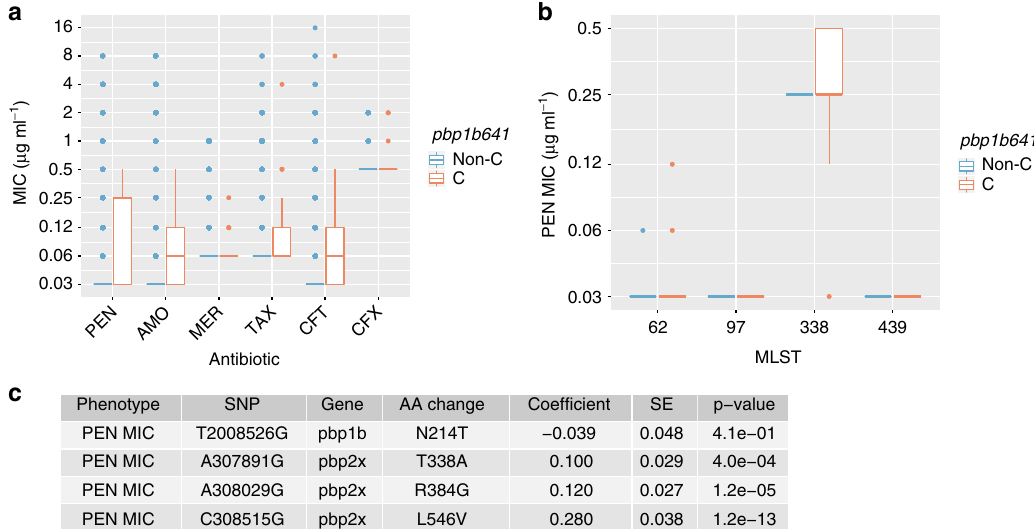
Fig. 3 Effects of pbp1b A641C on antibiotic resistance in clinical isolates. a Comparison of antibiotic MIC distribution between the non- pbp1b 641C isolates (blue) and pbp1b 641C isolates (orange) in the con fi rmatory cohort. PEN penicillin, AMO amoxicillin, MER meropenem; TAX cefotaxime, CFT ceftriaxone, CFX cefuroxime. b Comparison of PEN MIC distribution between the non- pbp1b 641C isolates (orange) and pbp1b 641C isolates (blue) within the same multi-locus sequence type (MLST). The four MLSTs containing both pbp1b 641C and non- pbp1b 641C isolates are shown. In all boxplots, center line is the median and the two box bounds are the fi rst and third quartile. A whisker is 1.5-interquartile range from the closest box bound. Data outside the whiskers are plotted as dots. c Association between the pbp1b A641C variant and increased PEN MIC (log2 transformed) assessed by a linear mixed-effects model (LMM) controlling for population structure. SNPs are relative to reference TIGR4 genome. SNP T2008526G corresponds to the pbp1b A641C mutation and the others three SNPs are known to conferring β -lactam resistance. Coef fi cient indicates the increase in log 2 (PEN MIC) associated with the alternative allele compared to the reference allele. SE is the standard error of the coef fi cient. Coef fi cients, SEs, and P -values were derived from fi tting the MIC and genotype data to the